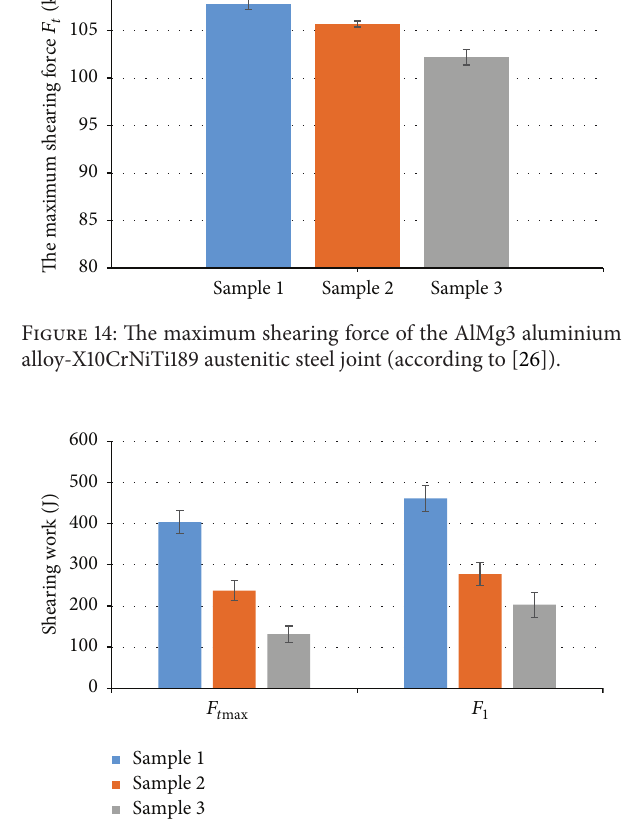
Figure 15: The results of shearing work of the investigated AlMg3 aluminium alloy-X10CrNiTi189, austenitic steel joints, determined for two variants of shearing pattern (according to [26]).